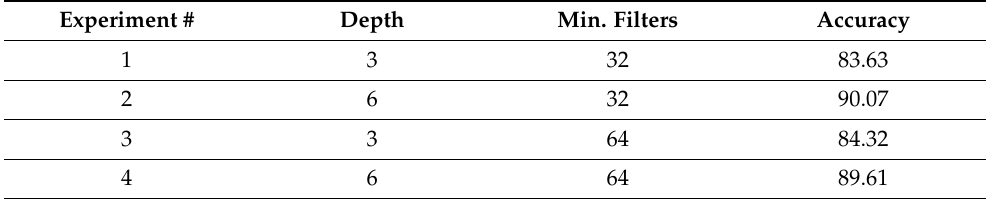
Table 6. Binary accuracy score for the Res-U-Net depends on model parameters on the Dataset #2. Experiment # Depth Min.